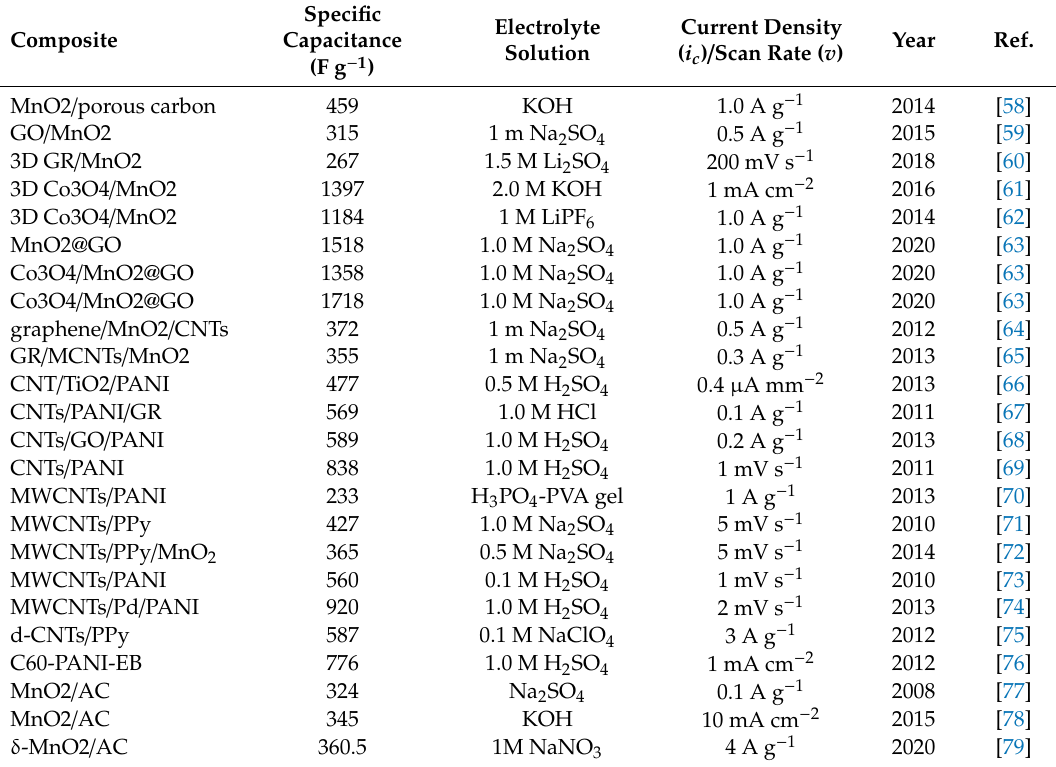
Table 4. Specific capacitance of various